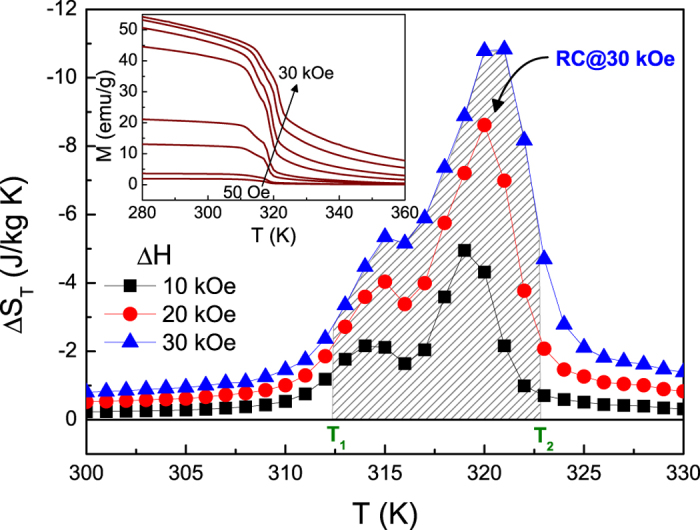
Temperature dependence of isothermal entropy change ΔST for Ni55.8Mn18.1Ga26.1 alloy at different magnetic fields.The inset shows temperature dependence of magnetization under various magnetic fields for this sample.